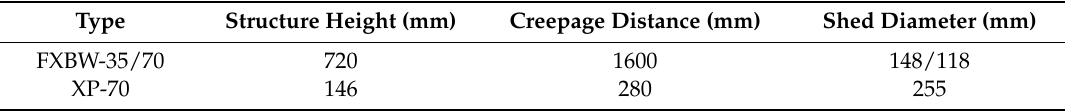
Table 2. Basic Parameters of the Insulators.